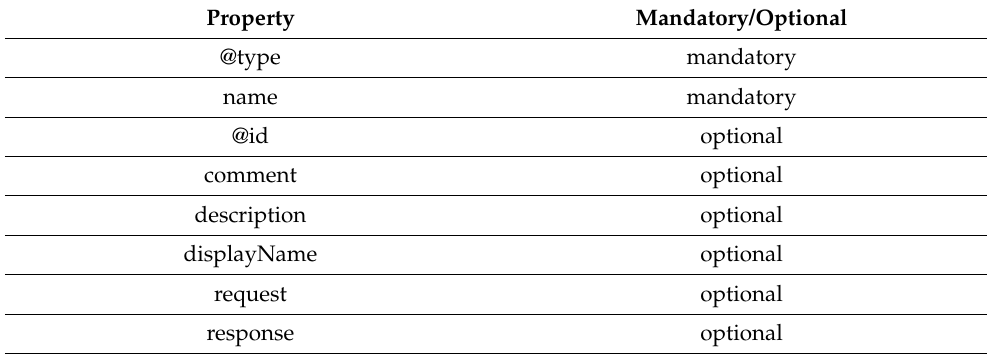
Table 9. Properties of the Command class.